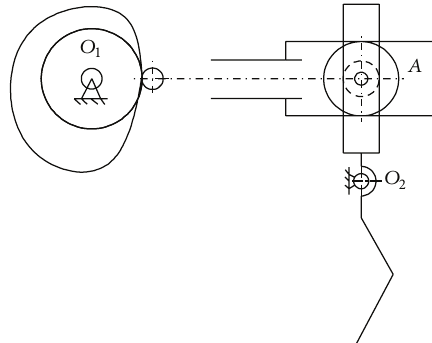
Figure 8: The principle of the hip joint cam kinematics.